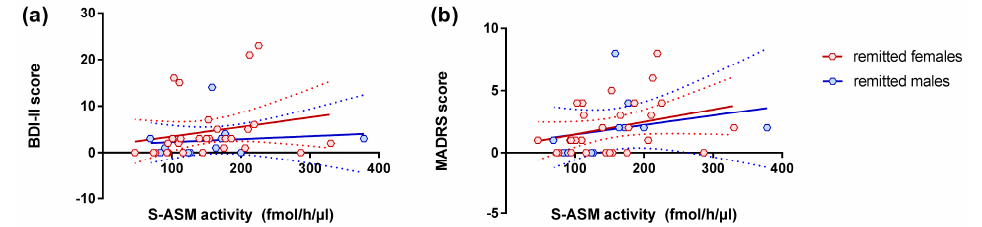
Figure 2. Positive correlation of serum acid sphingomyelinase (S-ASM) activity with depression severity assessed by ( a ) BDI-II (self-report) and ( b ) MADRS (administration by a clinician) inventories for female (red) and male (blue) remitted patients at study inclusion. Individual data with linear regression line and 95% confidence intervals.